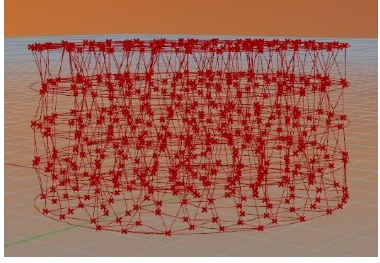
Figure 2. Structure obtained after applying the model to a disk shape.